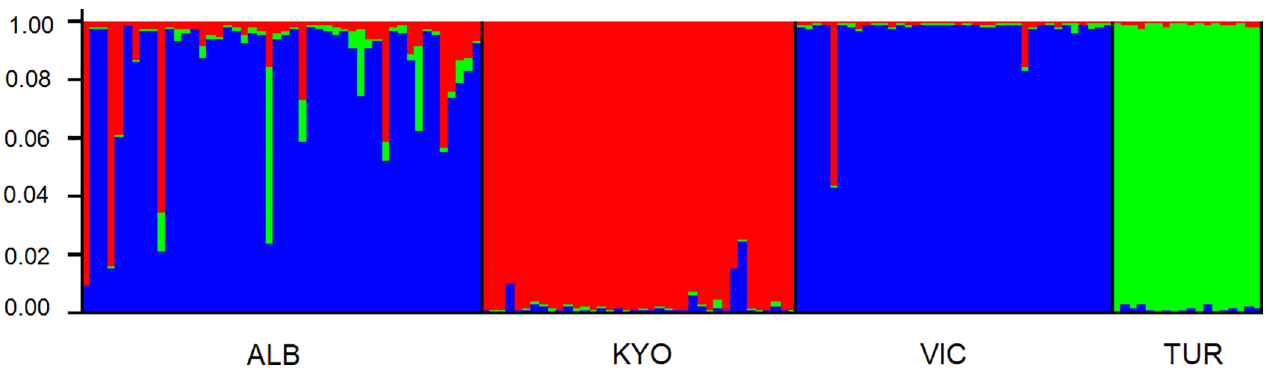
Fig 5. STRUCTURE [59] bar plot for Nile perch stock of East Africa populations; ALB—Lake Albert, KYO—Kyoga, VIC -Victoria and TUR—Turkana. The bar plot shows the proportion of genome ancestry assigned to three genetic clusters represented by blue, red and green colours. Lake Victoria and Albert individuals were assigned to one major cluster (blue) and Kyoga (red), while Turkana to another separate cluster (green).